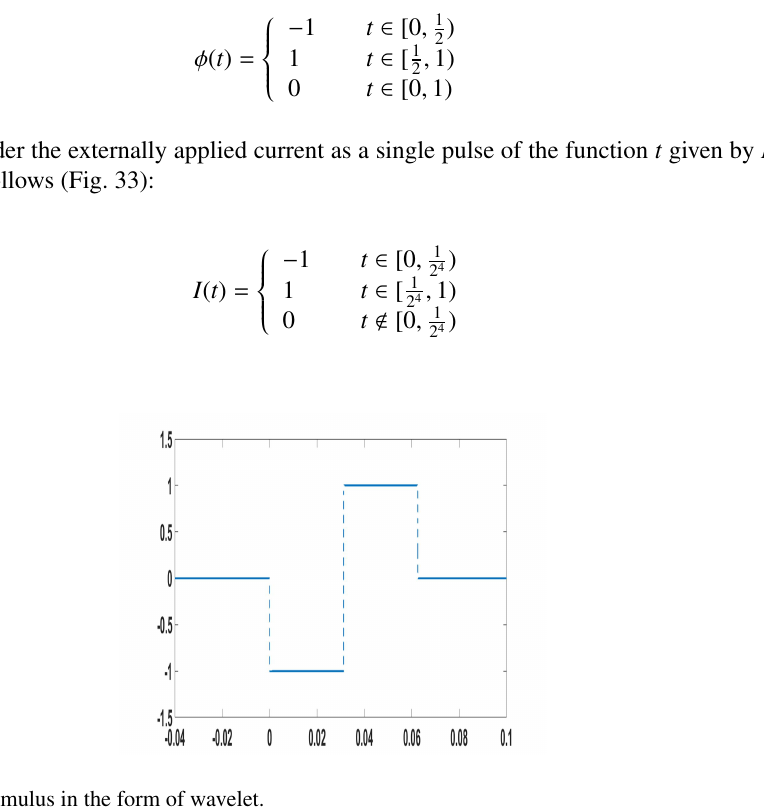
Figure 33. Stimulus in the form of wavelet.